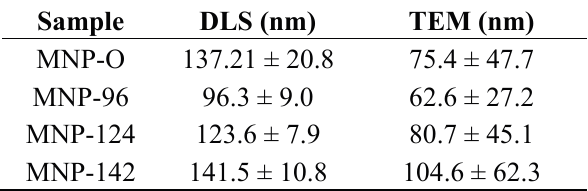
Table 1. Comparison of average hydrodynamic diameters measured using DLS and average core diameters determined using TEM for MNP-O, MNP-96, MNP-124, and MNP-142